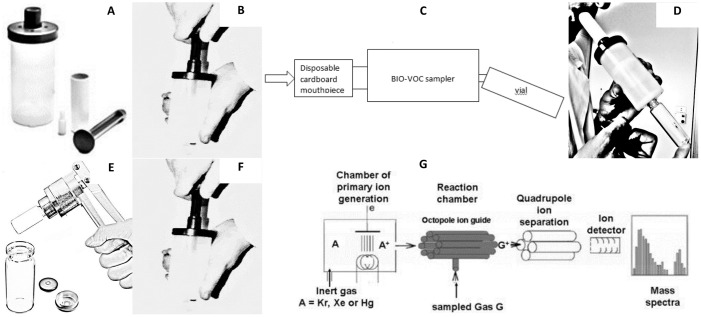
Explanation of the sampling procedure and the VOCs measurement by IMR-MS.A) breath sampler with disposable cardboard mouthpiece and the pushrod; B) connect the pushrod to the sampler and flush the sampler by pulling and pushing the rod in and out two or three times; C) remove to rod and connect the disposable mouthpiece to the sampler, placing the glass vial on the other side; D) have the patient breath normally and then keep exhaling trough the mouthpiece until their lungs are emptied; E) crimp airtight the glass vial with the appropriate crimp cap; F) throw away disposable mouthpiece and clean the breath sampler by flushing it two/three times using the pushrod; G) the glass vial, preserved at –20°C, is analyzed with the IMR-MS method, schematized here (reported from Defoort and colleagues [35]) and described in detail in Hornuss and colleagues [36].